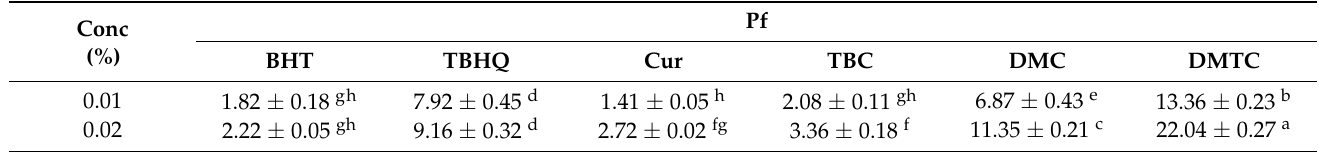
Table 2. Protection factors (Pf) of Cur and its derivatives at various concentrations (0.01 and 0.02%) at 100 °C.